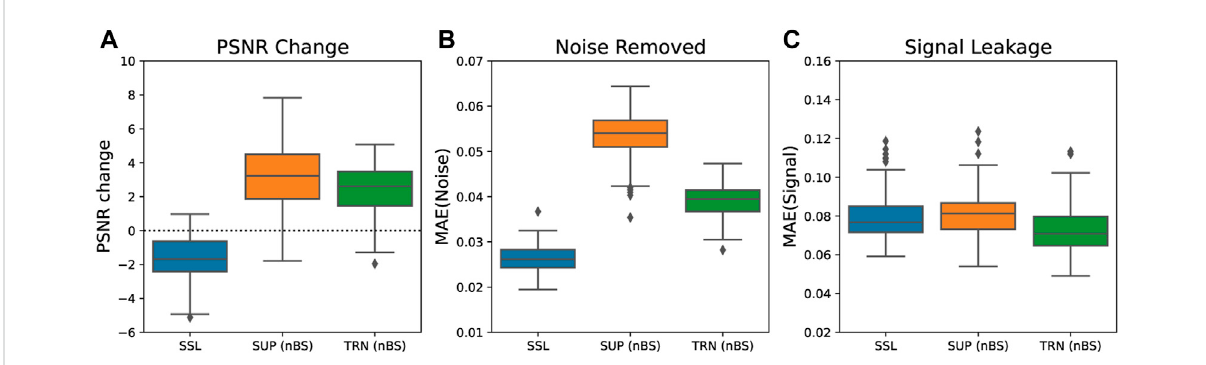
FIGURE 10 Comparison of denoising performance when the supervised network is trained in a conventional manner, i.e., when the blind-spot is only implementedfortheself-supervisedtrainingstages.Theboxplotsshow for100eventsthe (A) overallchangeinPSNR, (B) volumeofnoiseremoved, and (C) shows the amount of signal leakage encountered. The dashed line in (A) indicates a benchmark against the PSNR of the original, noisy data.